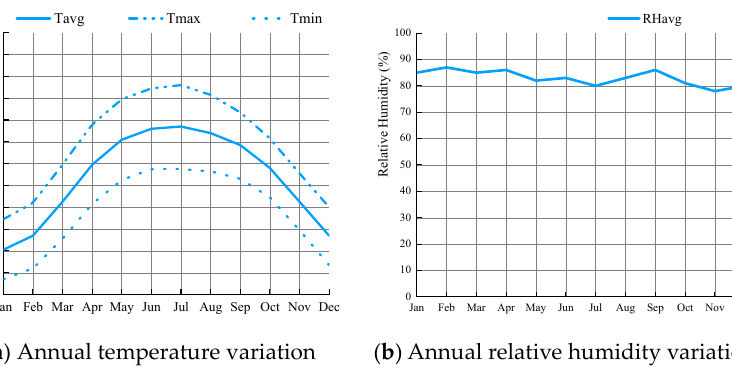
Figure 4. Climatic data in Haikou. Table 2. Design recommendations for each month of Haikou based on Mahoney table.